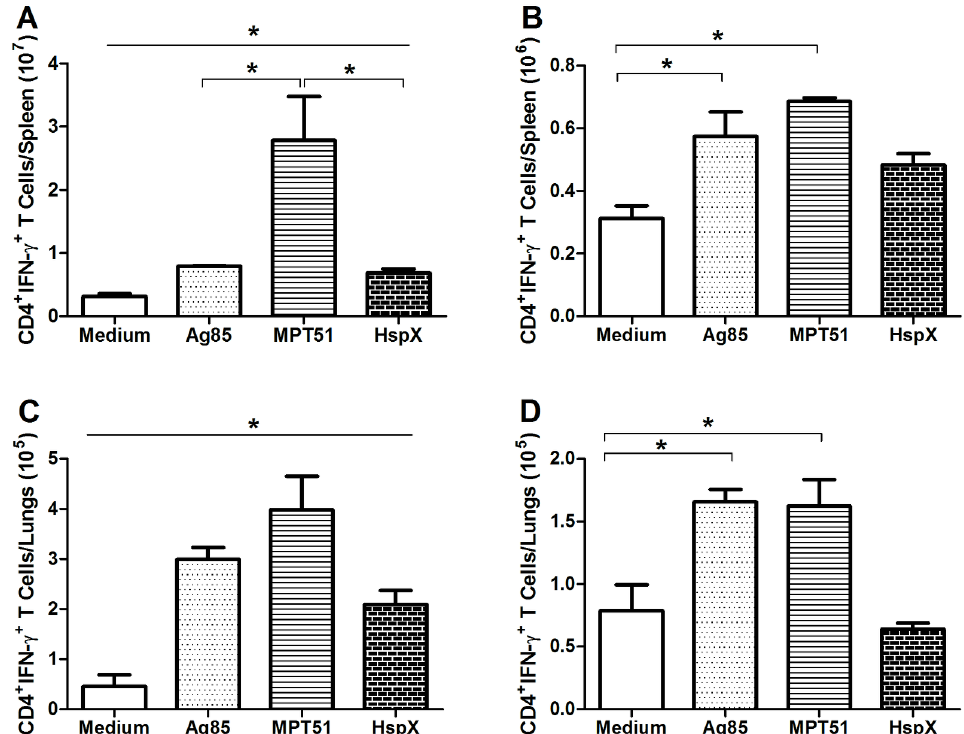
Figure 5. Levels of CD4 + IFN- c + T cells induced by exvivo stimulation with recombinant Ag85, MPT51, and HspX. Thirty days after vaccination, lung and spleen suspensions were stimulated ex vivo with Ag85, MPT51, HspX, or medium alone. The number of cells positive for CD4 and IFN- c was determined by flow cytometry. Lymphocytes were selected based on size and granularity. Gates were set to analyze CD4 + T cells, and then the fluorescence of antibodies detecting IFN- c + cells was recorded. (A–B) Spleen cells from mice vaccinated with (A) rBCG-CMX or (B) BCG. (C–D) Lung cells from mice vaccinated with (C) rBCG-CMX or (D) BCG. In A and C, all results were different from the medium stimulation. These data are representative of two independent experiments (N=6, *p ,